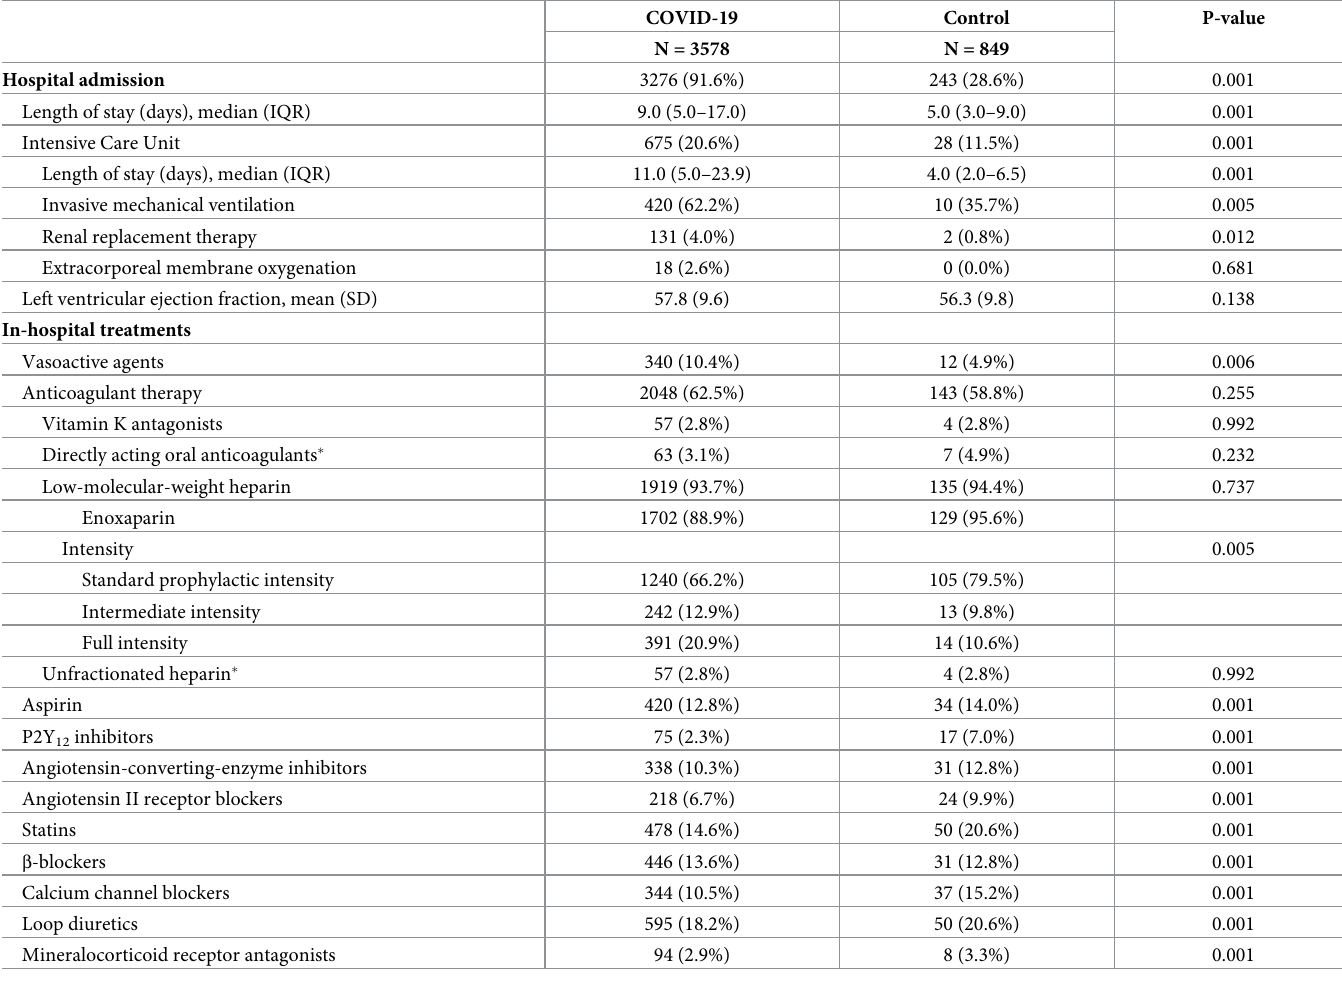
Table 2. In-hospital characteristics and